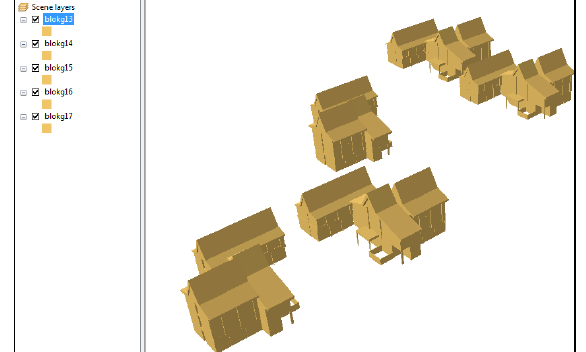
Figure 13 The visualize of 3D city